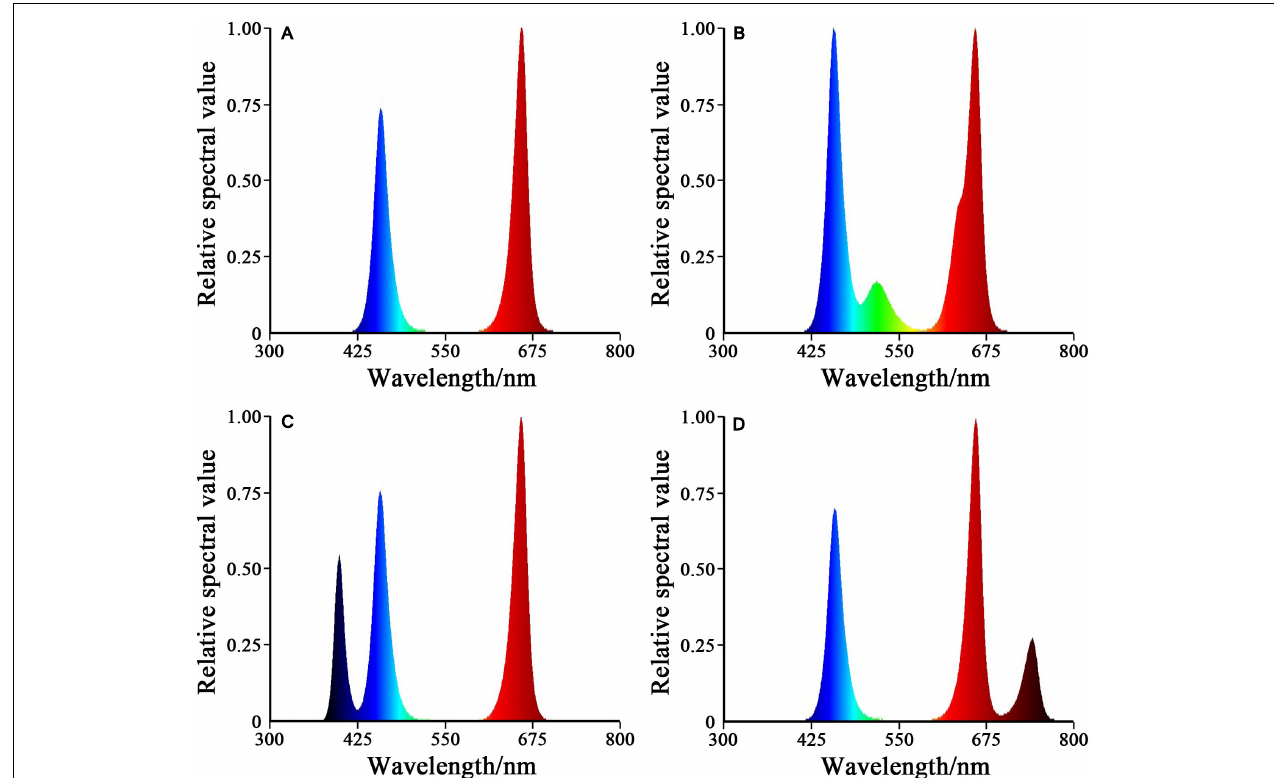
FIGURE 1 | Relative spectral value of four treatments. (A) RB, 75% red + 25% blue LED. (B) RBG, 60% red + 20% blue + 20% green LED. (C) RBP, 60% red + 20% blue + 20% purple LED. (D) RBF, 60% red + 20% blue + 20% infrared LED.